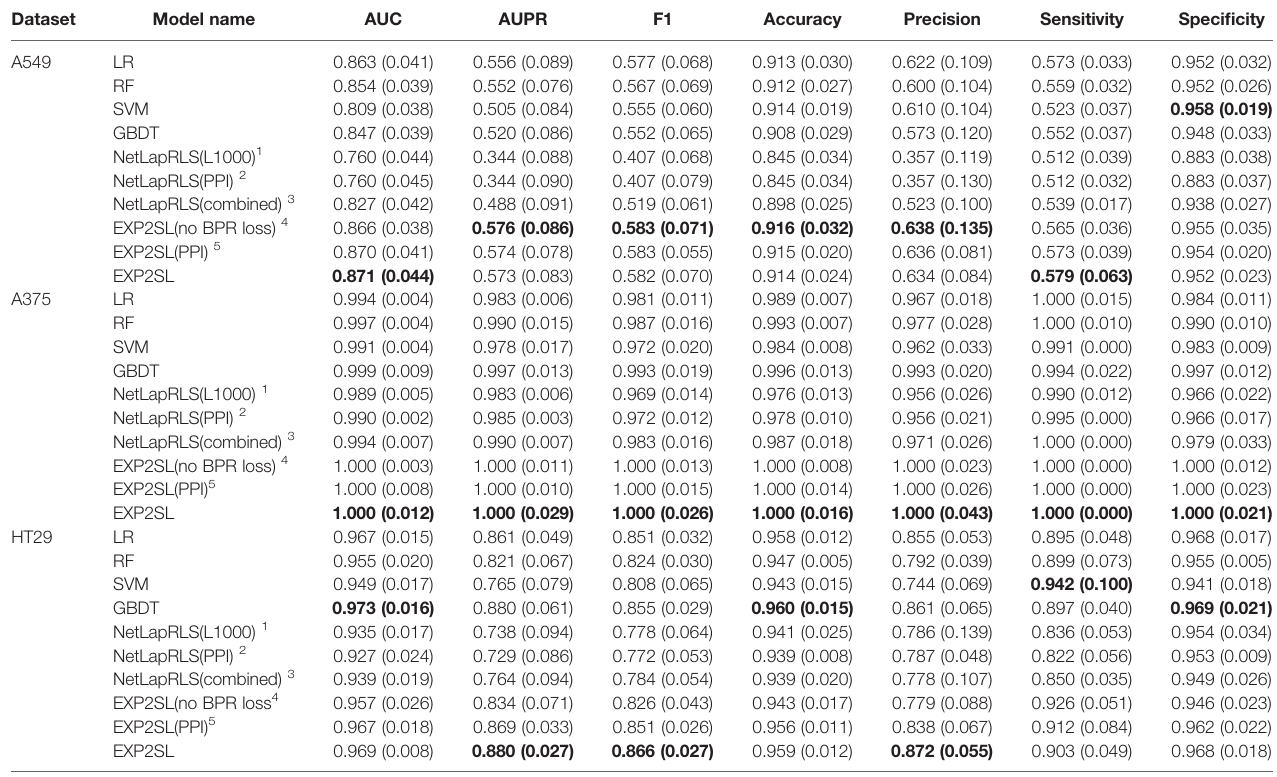
TABLE 2 | Performance evaluation in three different cell lines under the “ split pair ” setting. The mean and standard deviation (in brackets) of metrics over 10 repeats of 5-fold cross-validations are shown. The best results for each cell line and each metric are marked in bold.